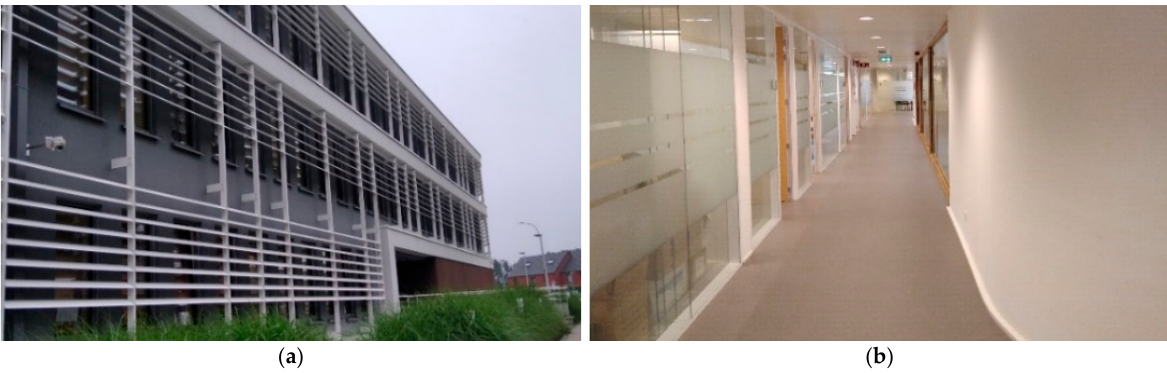
Figure 3. Clinic Saint ‐ Pierre, Brussels, Belgium: ( a ) building exterior; ( b ) building interior.